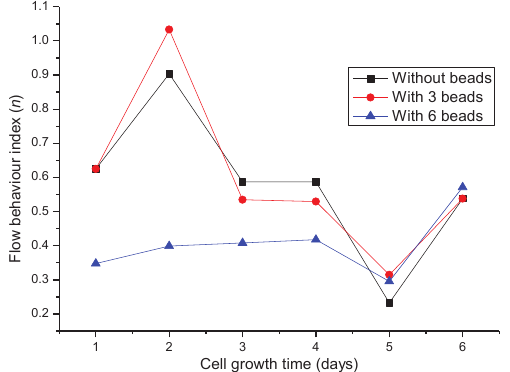
Fig. 7 – Variations in flow behavior index (n) of the pow- er-law fluid model as cell growth occurs with or without glass beads